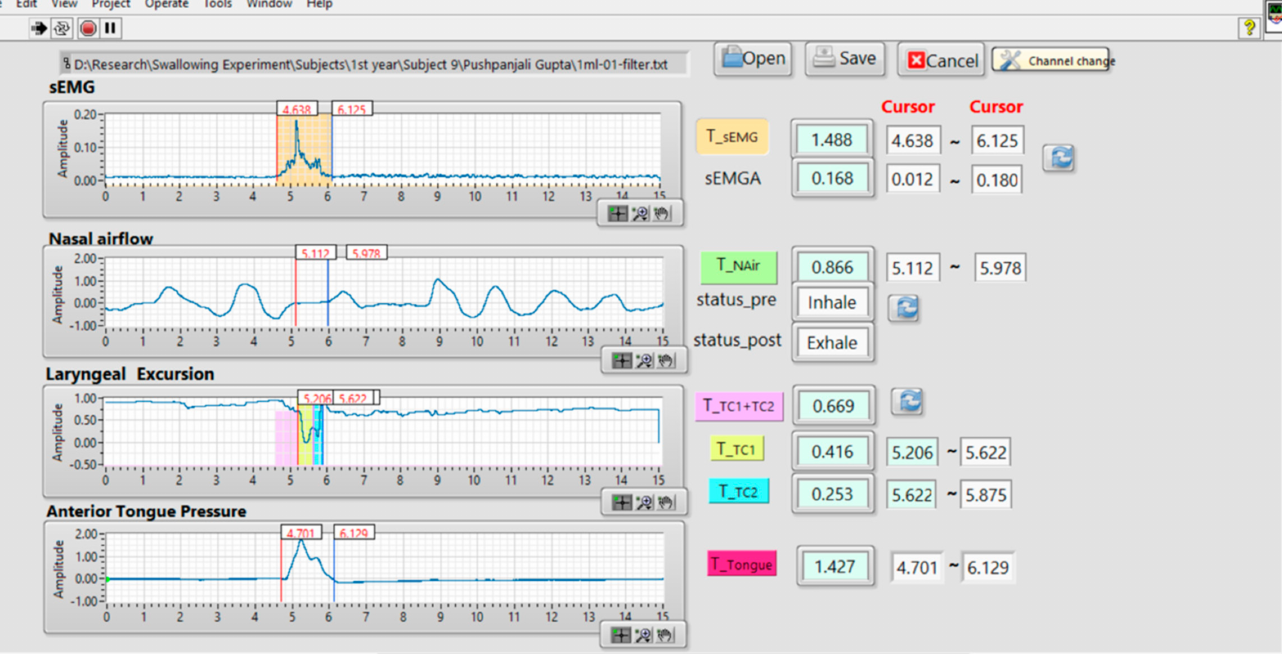
Figure 8. Snapshot of the autodetection program. This program was implemented in LabVIEW [21]